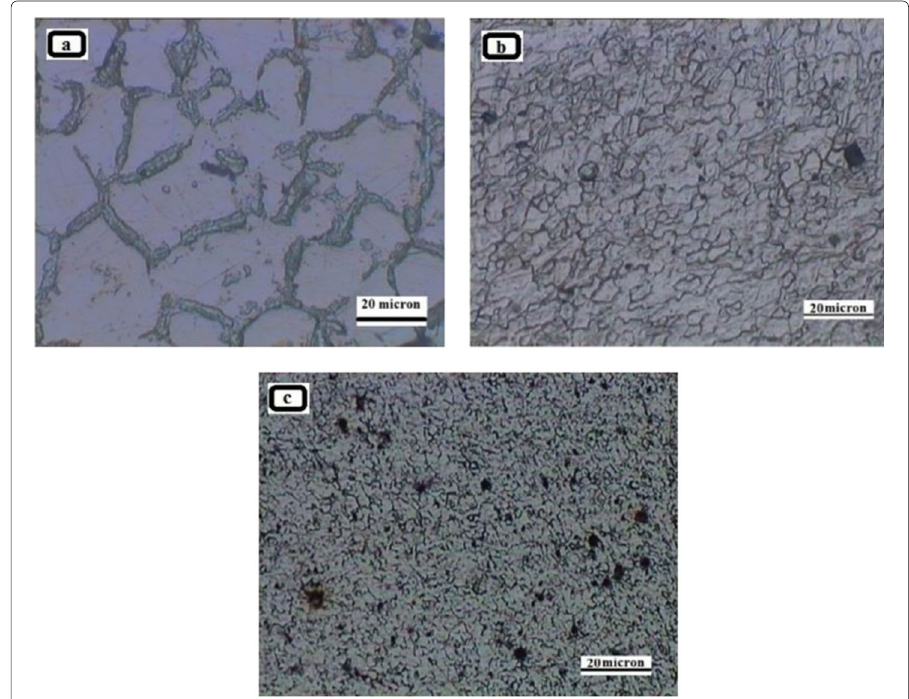
Fig. 8 Effect of ZrO 2 particles and multi pass FSP on microstructure of Mg-matrix [102]